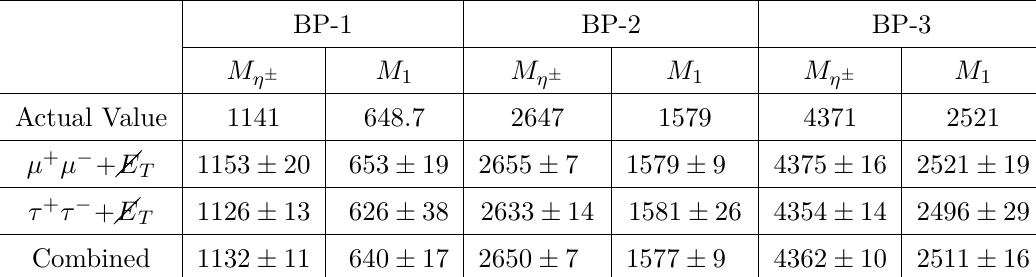
Table 5 . The actual values of benchmark points and corresponding fitted results for dimuon, ditau and combined channel. All the masses are in the unit of